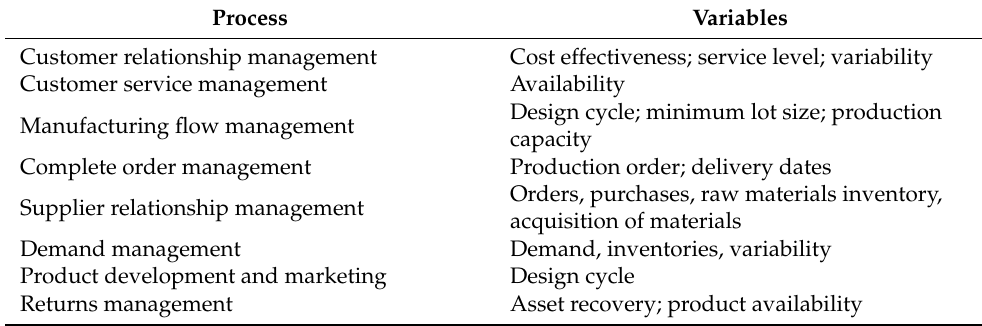
Table 1. Variables that affect